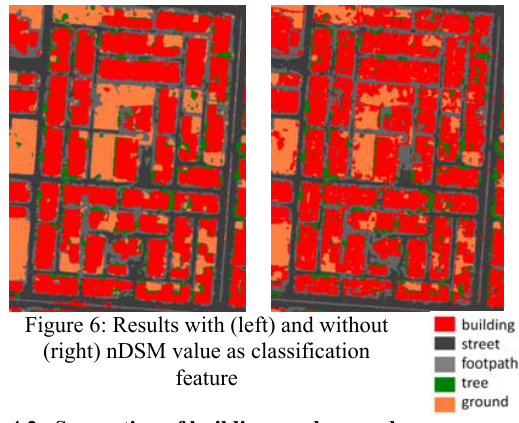
Figure 5: Classification results (LN: label noise tolerant logistic regression, LogReg: standard multi-class logistic regression; for the definition of "3Features" see text.